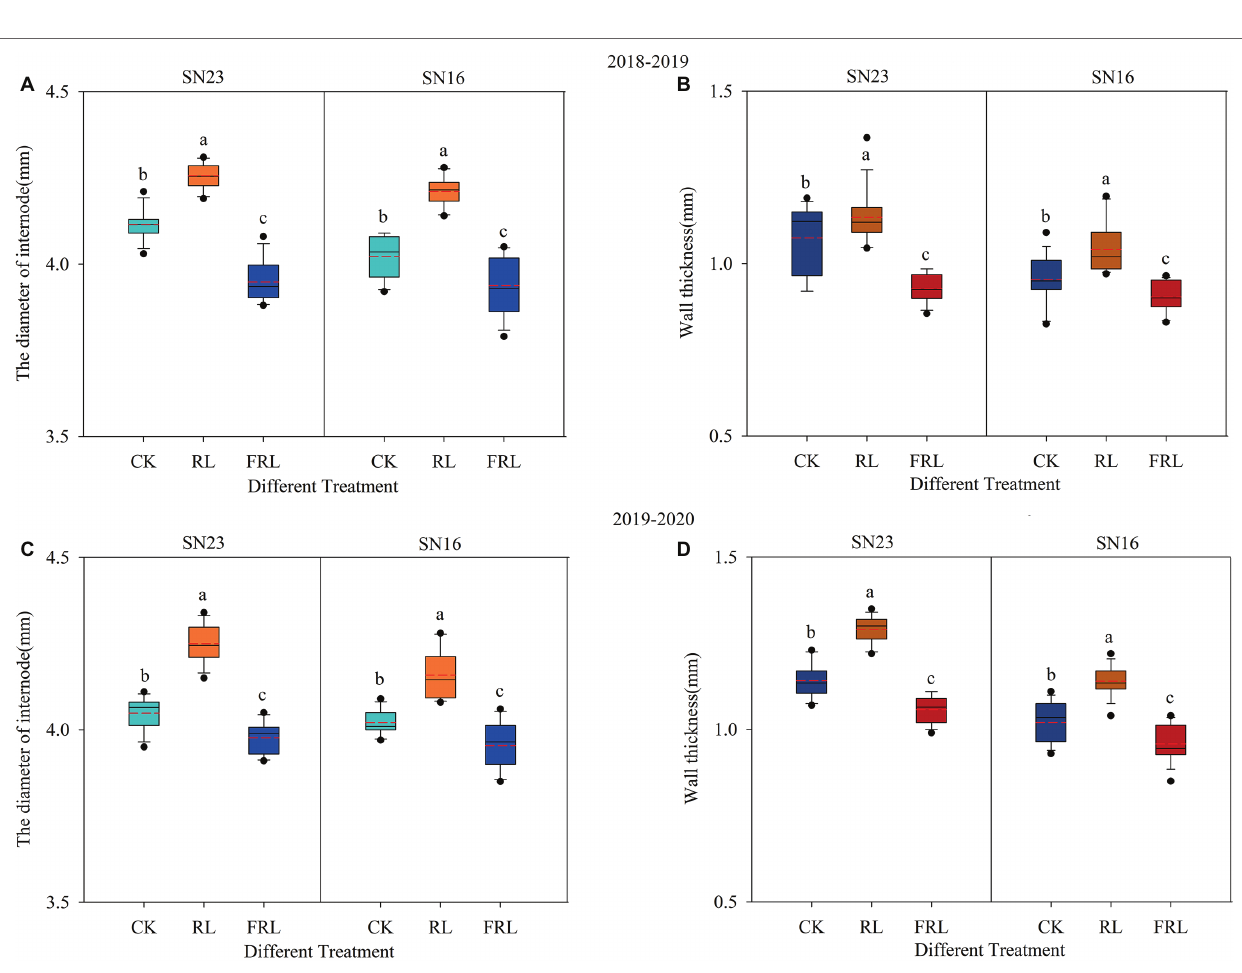
FIGURE 2 | The effect of light quality in population on diameter (A,C) and wall thickness (B,D) in wheat in 2018–2019 and 2019–2020 growing seasons, respectively. SN16 and SN23 represent the lodging-sensitive cultivar Shangnong16 and the lodging-resistant cultivar Shangnong23. CK represents the normal light, RL represents the red light, and FRL represents far-red light. Solid lines and red dotted lines indicate medians and means, respectively; box boundaries indicate upper and lower quartiles, whisker caps indicate 90th and 10th percentiles ( n = 12). Significant differences between treatments according to the least significant difference (LSD; p <